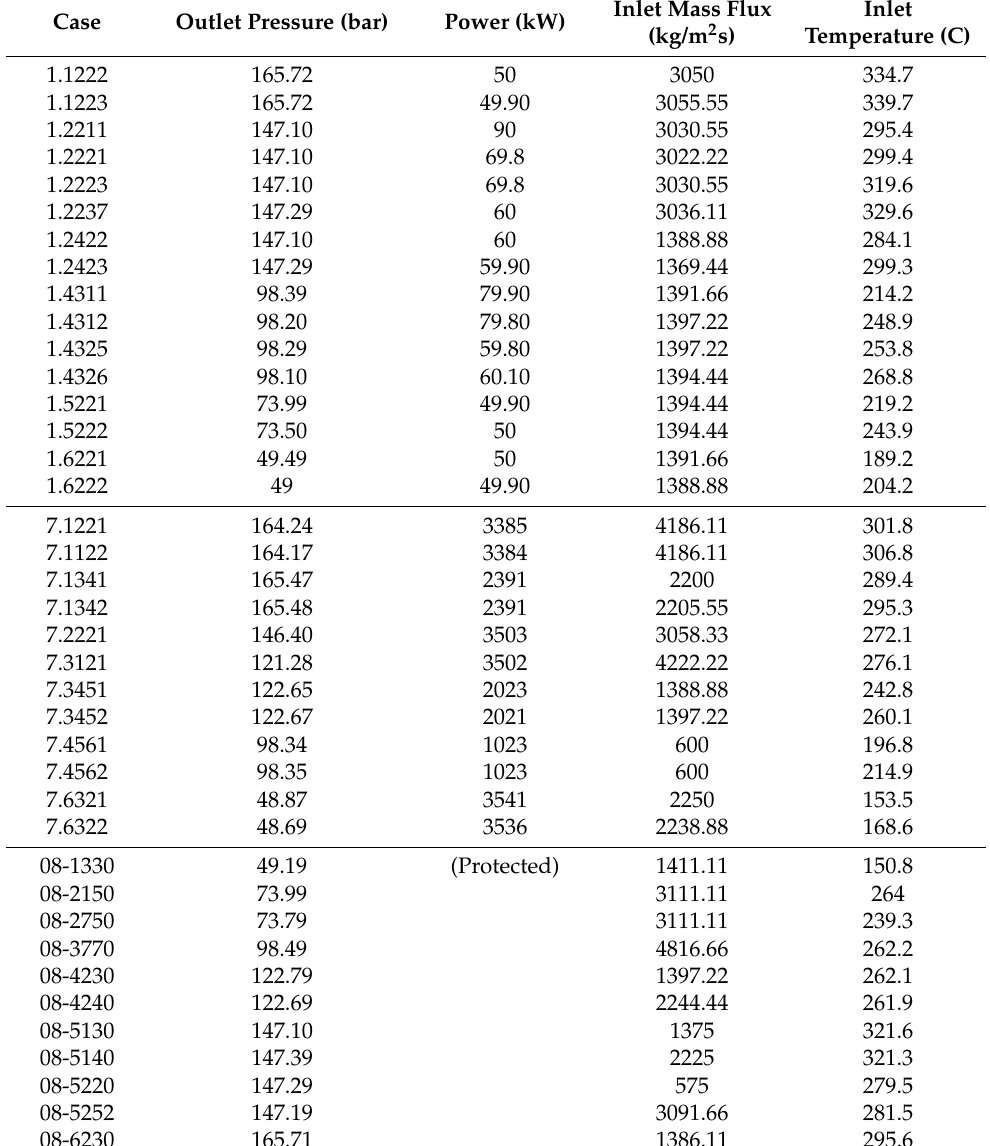
Table 5. 1 × 1 (S1) and 5 × 5 (B7 and A8) initial and boundary conditions from the PSBT